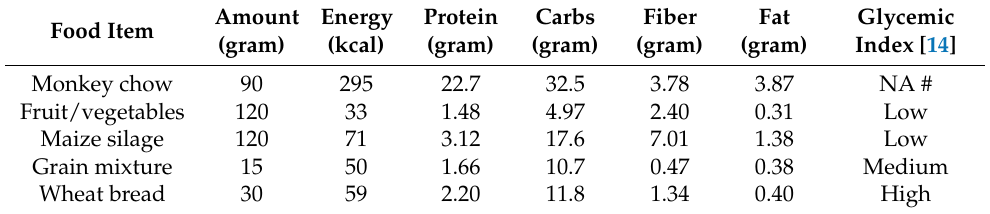
Table 1. Nutritional values of food items in the daily diet of female long-tailed macaques at BPRC based on the (average) amount fed per animal. Information was obtained from the food item’s manufacturer or The Dutch Food Composition Database (NEVO, online version 2019/6.0; Table